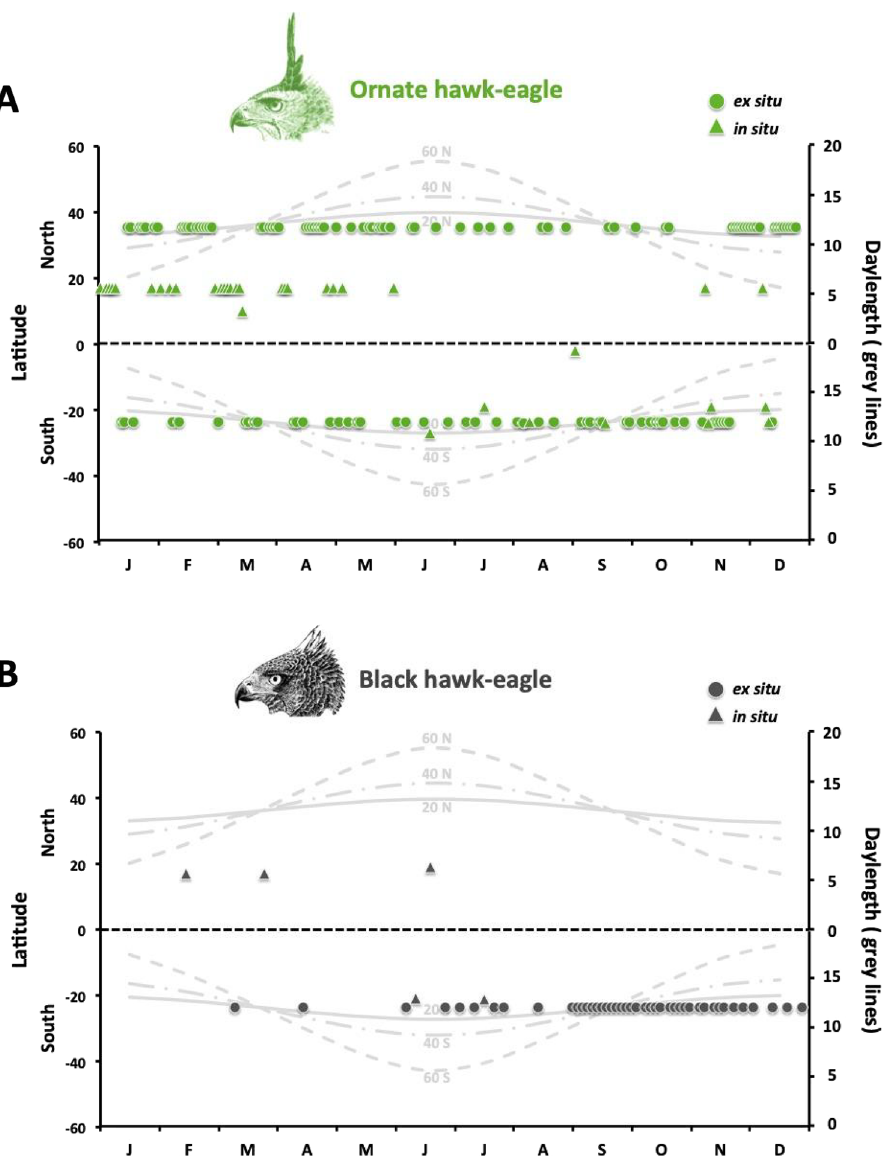
Figure 1. Annual distribution of clutches in ( A ) Ornate hawk-eagle ( Spizaetus ornatus ) and ( B ) Black hawk- eagle ( Spizaetus tyrannus ) females. Circles and triangles represent clutch events recorded in captivity and in the wild, respectively. Solid, dash-dotted and dashed gray lines depict annual variations in daylength at latitudes 20°, 40° and 60° of the northern and southern